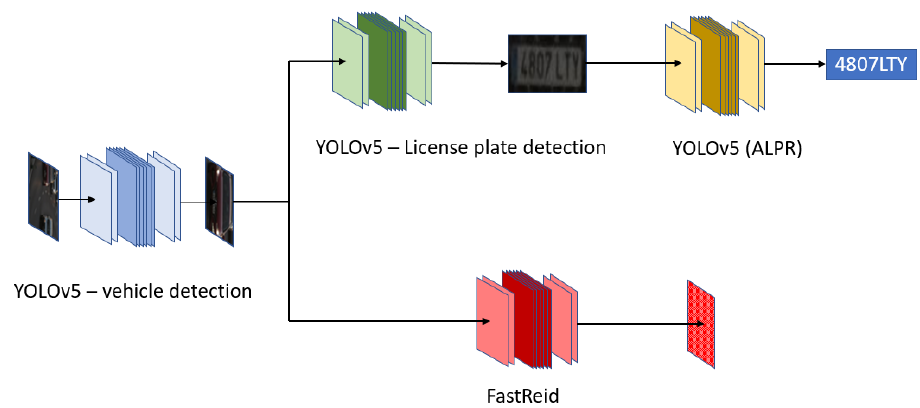
Figure 10. Proposed multi-neural network architecture.